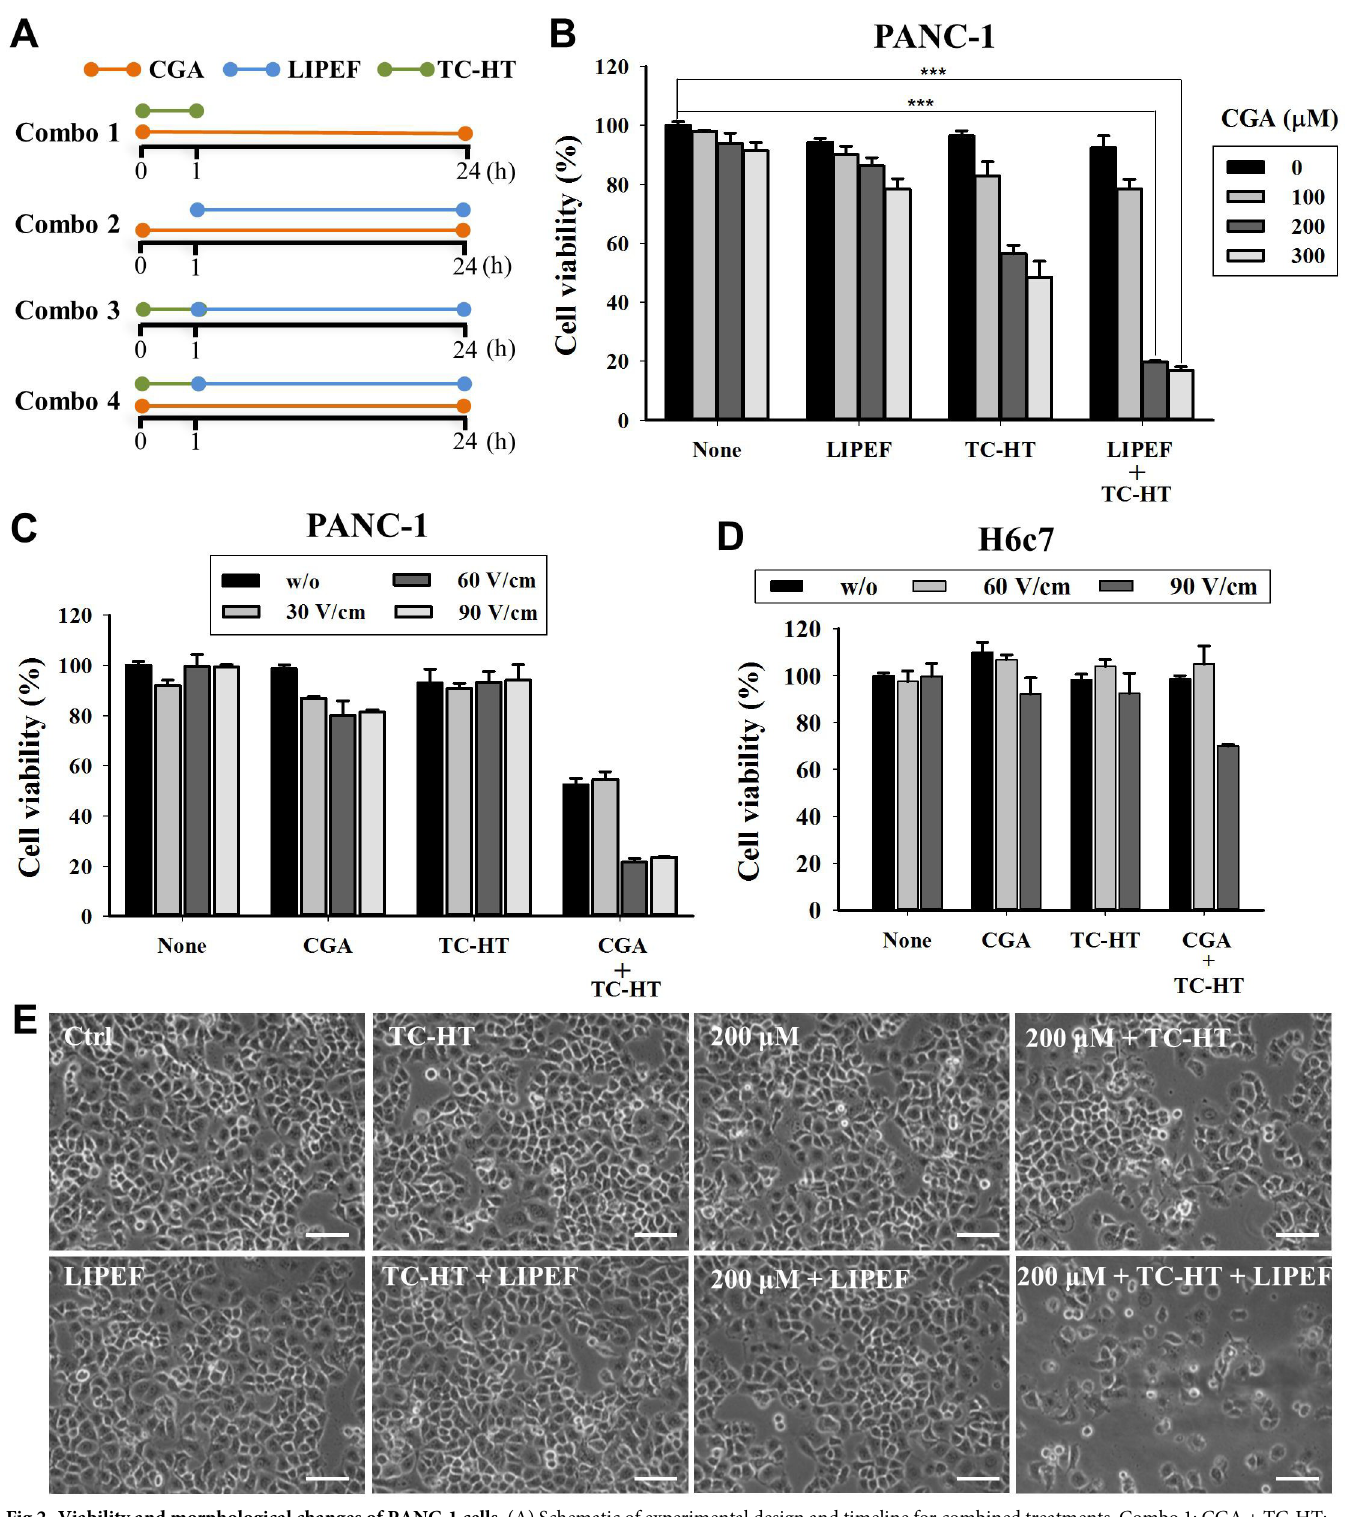
Fig 2. Viability and morphological changes of PANC-1 cells. (A) Schematic of experimental design and timeline for combined treatments. Combo 1: CGA + TC-HT; Combo 2: CGA + LIPEF; Combo 3: TC-HT + LIPEF; Combo 4: CGA + TC-HT + LIPEF. (B) Cells were treated with CGA (100, 200, and 300 μ M), TC-HT (10-cycles), and LIPEF (60 V/cm) alone, in double or triple combination for 24 h, and then cell viability was determined by MTT assay. (C) The viability of PANC-1 cells subjected to 200 μ M CGA, 10-cycles TC-HT, and different intensities of LIPEF. (D) The viability of H6c7 cells was evaluated by MTT assay after triple treatment with 200 μ M CGA,